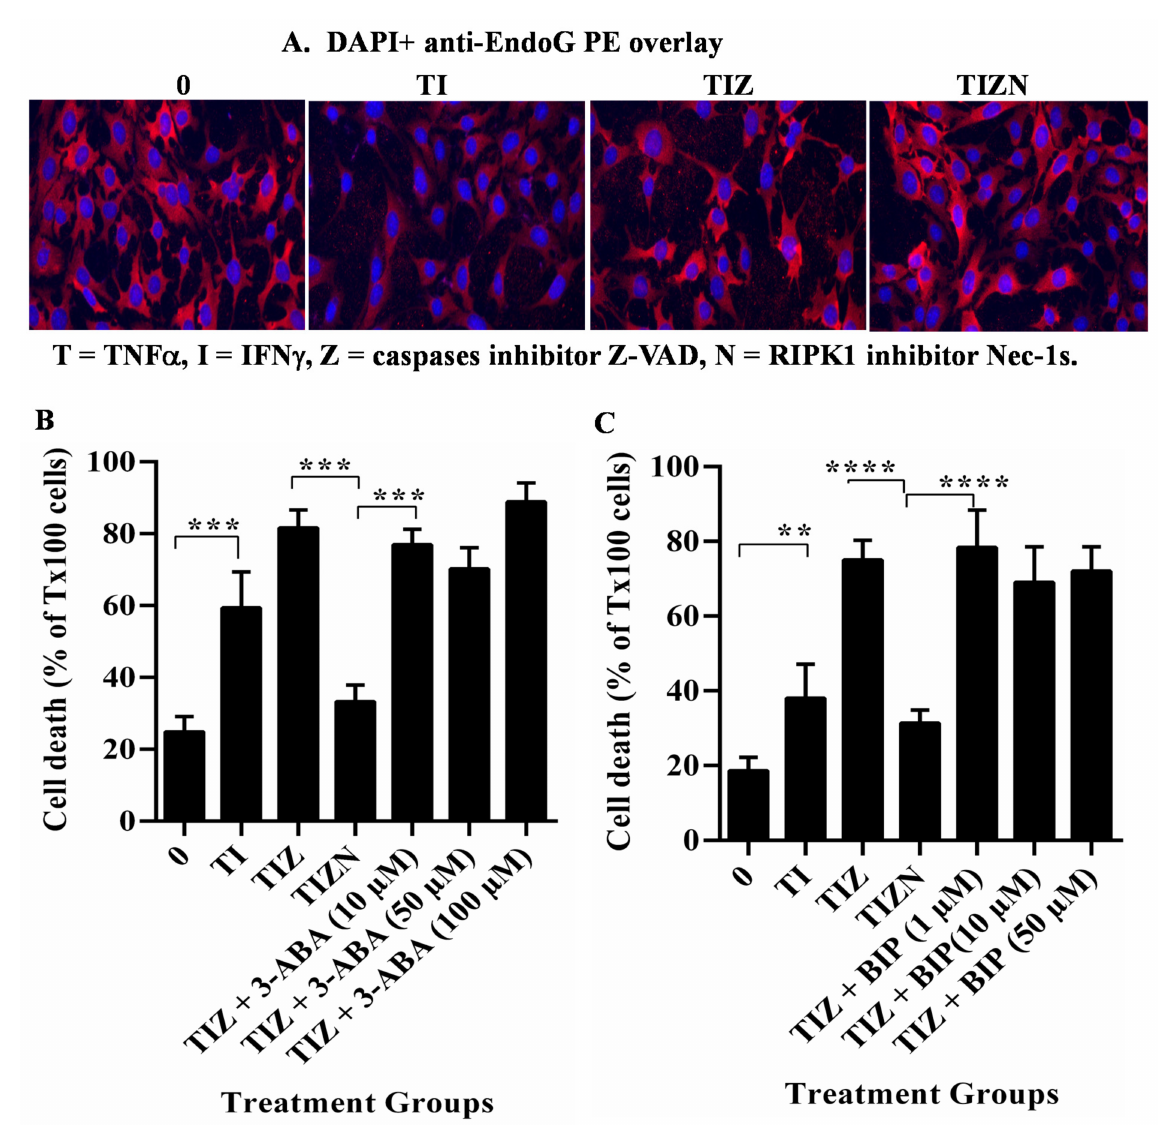
Figure 5. EndoG, PARP-1 and BAX do not participate in MVEC necroptosis. ( A ) WT MVECs were subjected to the in vitro simulation of IRI treatment as above and were fixed with 4% formaldehyde solution and permeabilized with 0.1% Triton X-100. The cells were incubated with antimurine EndoG followed by anti-rabbit PE-conjugated antibody. The nucleus was stained with DAPI. The same experiment was repeated three times. Representative individual cell images are shown. ( B ) MVECs were subjected to in vitro simulation of the IRI treatment. PARP-1 inhibitor 3-ABA or ( C ) BAX inhibitor BIP was added before the treatment. % EC death = sample count/count of Triton-X100-treated cells. Data are shown at 24 h post-reoxygenation as the mean ± SD of triplicates and representative of at least 3 independent experiments. ** p ≤ 0.01, *** p ≤ 0.001 and **** p ≤ 0.0001; 1-way ANOVA and Tukey’s multiple